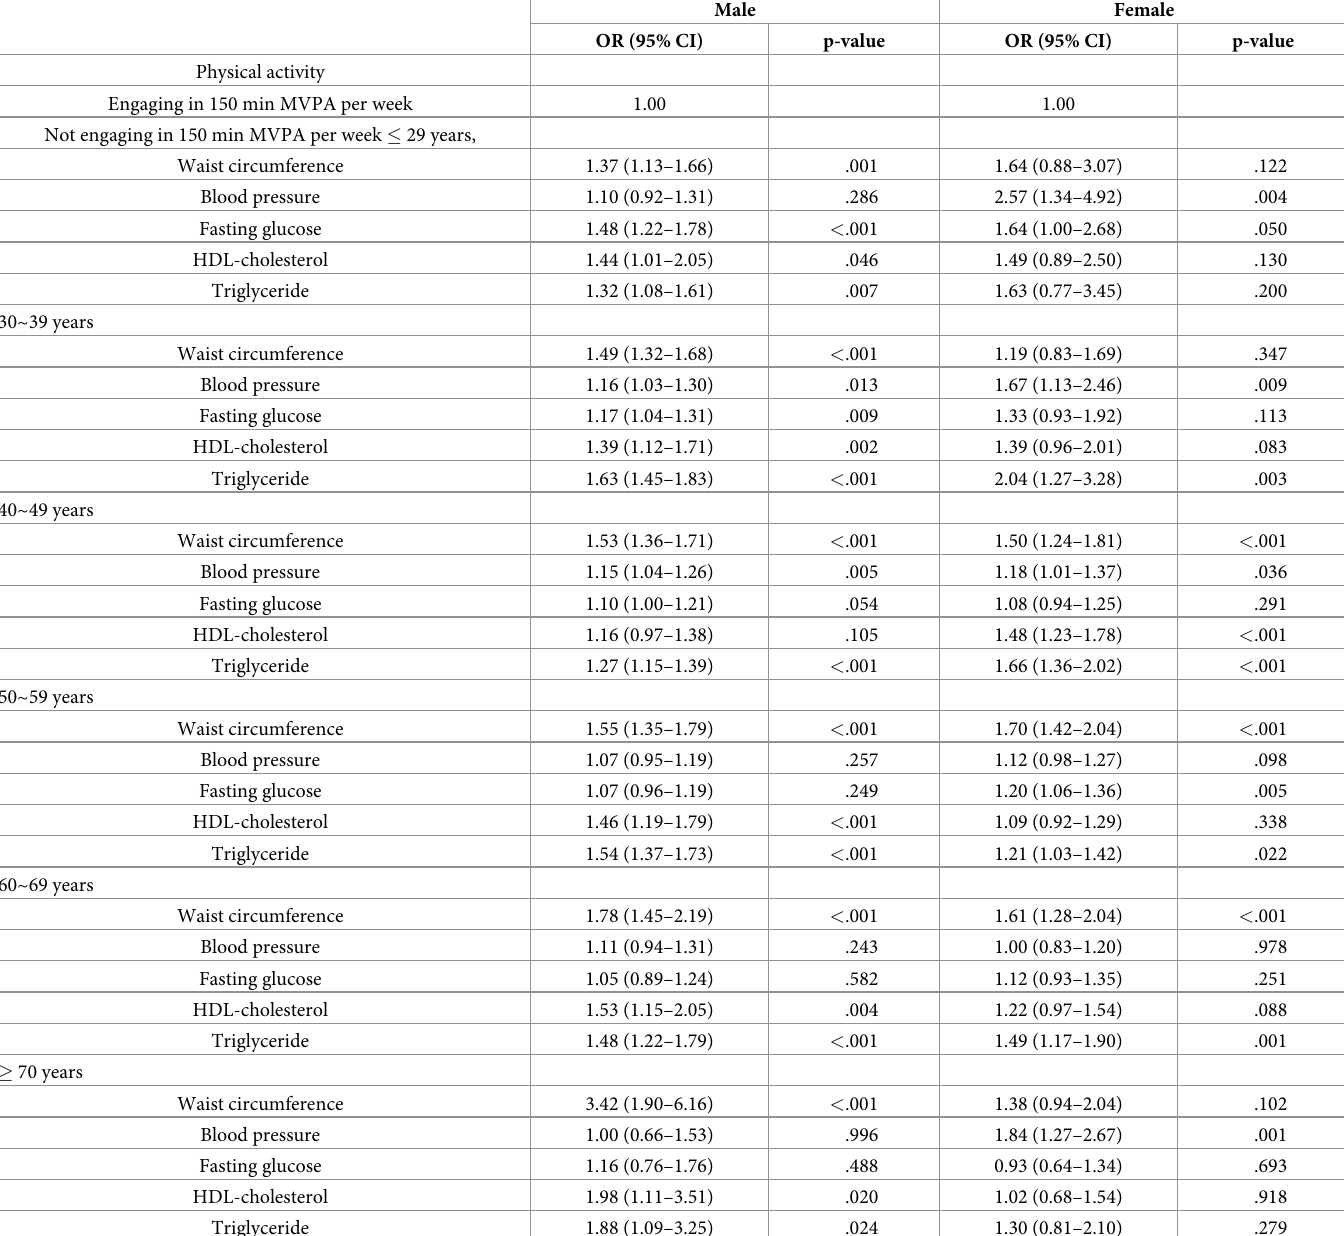
Table 4. Independent associations of IPAQ physical activity time with metabolic